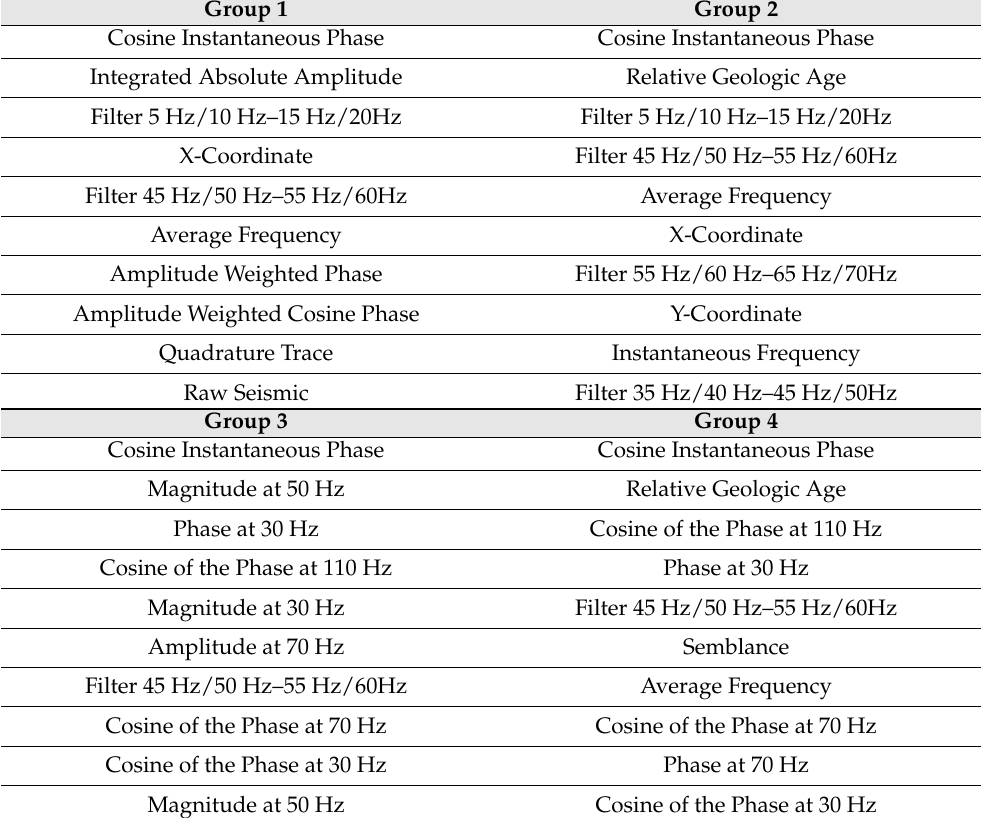
Table 1. Top ten attributes selected by stepwise regression to predict